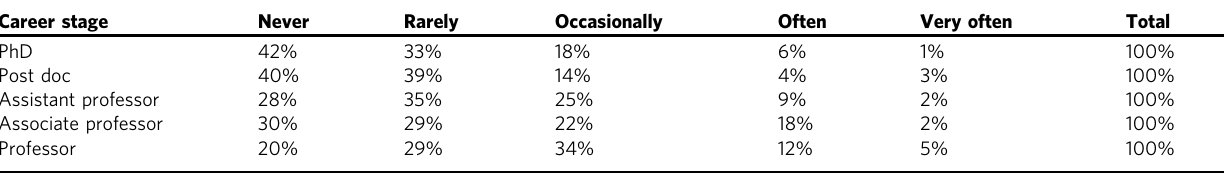
Table 4 Frequency of references to fi ction in publications by career